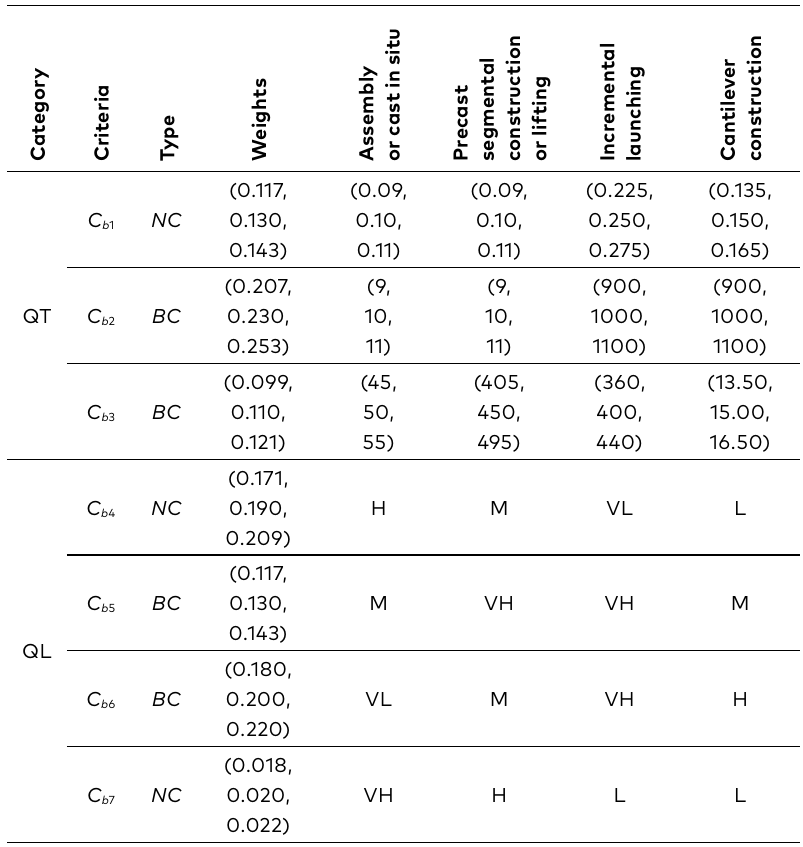
Table 4. The decision-matrix of the Construction Methods problem